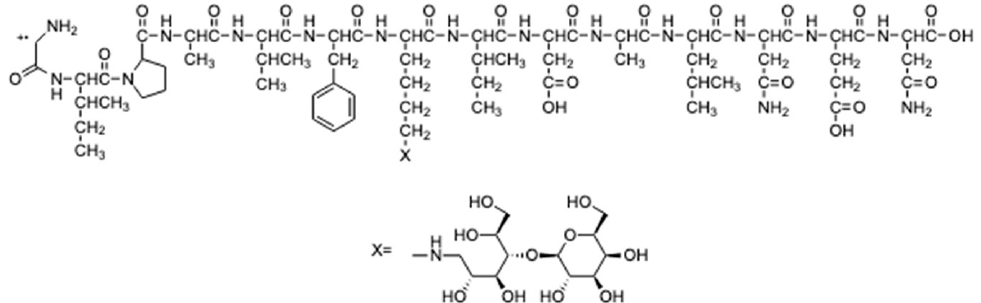
Figure 5. Peptide fragment identified in the HRMS/MS spectrum with only one lysine.